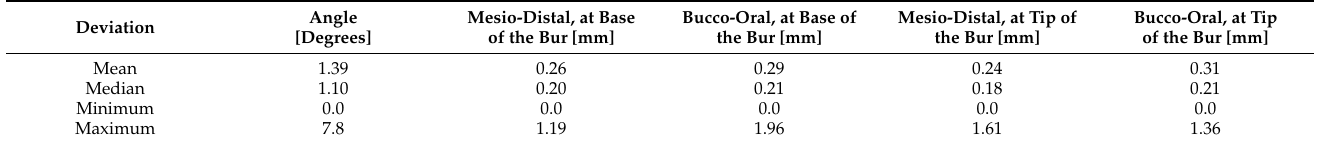
Table 1. Deviation between planned and prepared access cavities regarding angle deviation and mesio-distal and bucco-oral deviation at the tip and base of the